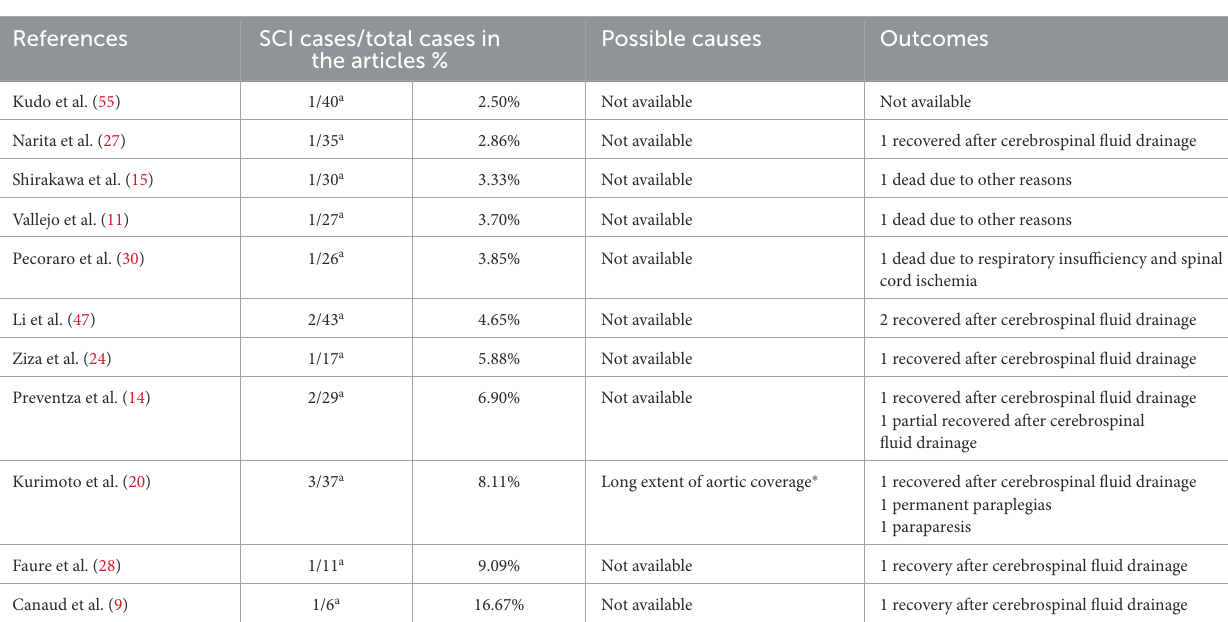
TABLE 8 Possible causes and outcomes of SCIs in included